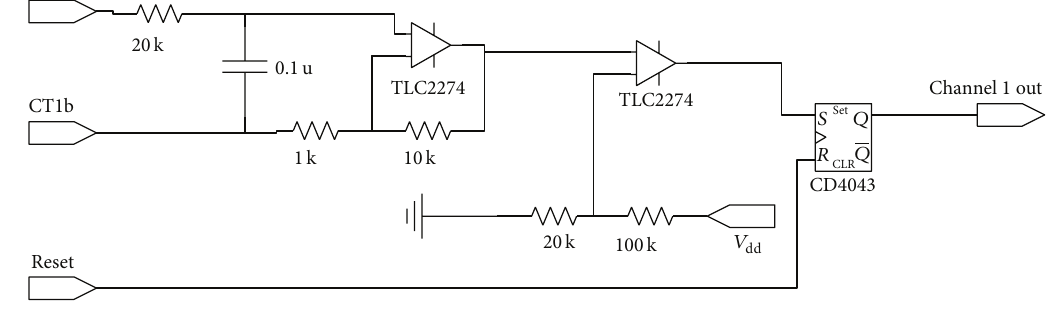
Figure 10: Schematic of GFCI.